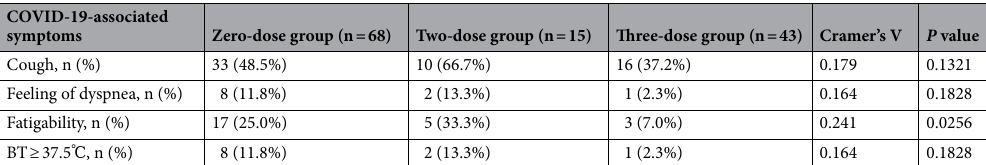
Table 2. COVID-19-associated symptoms in RT-PCR test-positive individuals by the number of completed vaccine doses. The prevalence of COVID-19-associated symptoms among RT-PCR test-positive individuals who were not vaccinated or within 7–90 days after the second or third vaccine dose during the Omicron outbreak in Japan are listed. Although three of the four symptoms did not reach statistical significance, the prevalence of all symptoms was slightly lower in the three-dose group than that in the two- or zero-dose group. P -values were obtained using the chi-square test. BT body temperature, COVID-19 coronavirus disease 2019, RT-PCR reverse transcription-polymerase chain